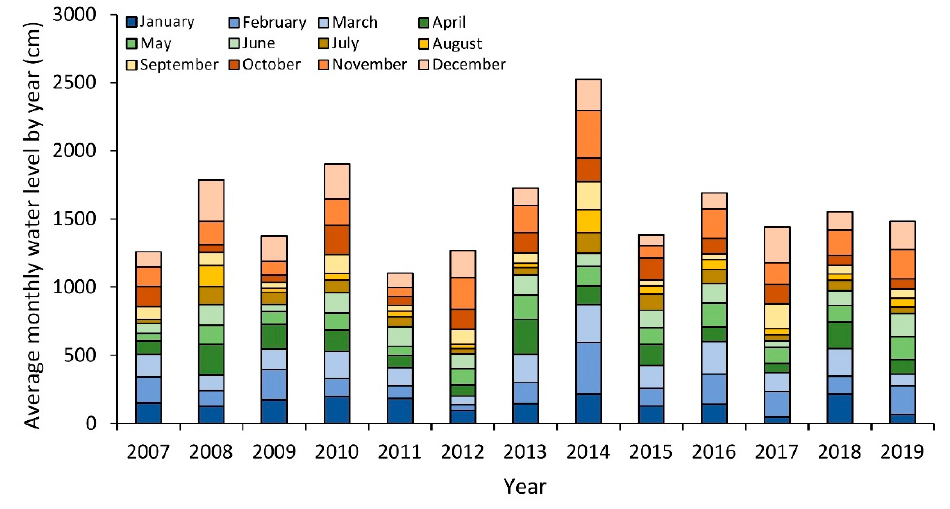
Figure 2. Average monthly water levels at the Stržen–Gorenje Jezero monitoring station (obtained from the Slovenian Environment Agency).